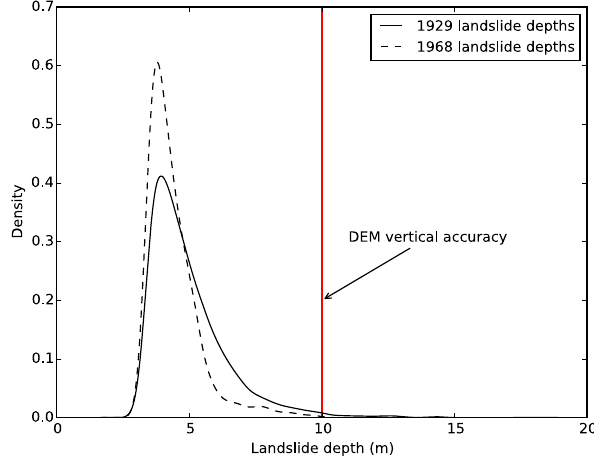
Figure D1. Distribution of landslide depths for the 1929 and 1968 earthquakes, estimated using global best-fit relationship between landslide area and volume (Larsen et al., 2010). Vertical accuracy of elevation data is indicated in